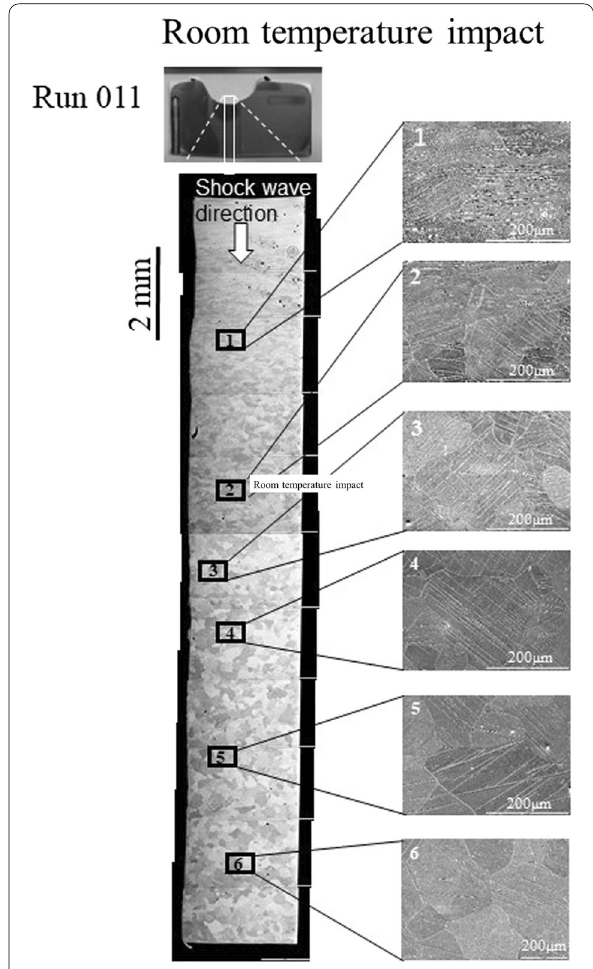
Fig. 6 The optical and backscattered electron (BSE) images from the top to the bottom of the target sample of the room temperature impact (Run 011) and its magnified secondary electron images (SEI). The twins are observed in the